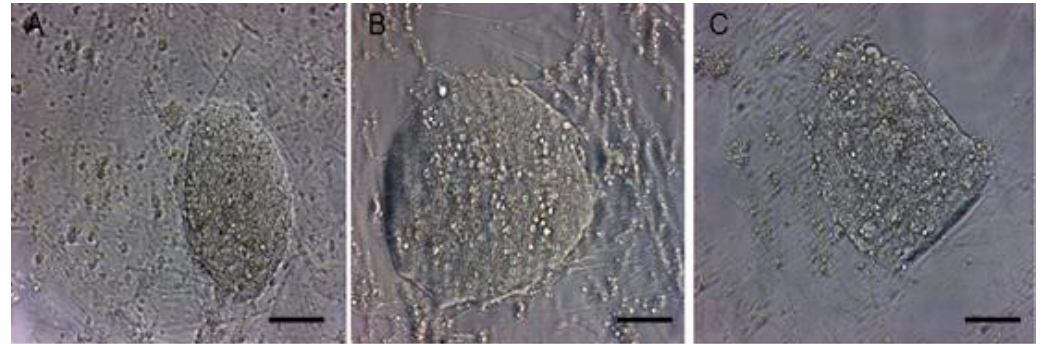
Figure 1. ES cell clone shapes cultured for 7 days in the media containing 15% KSR ( A );